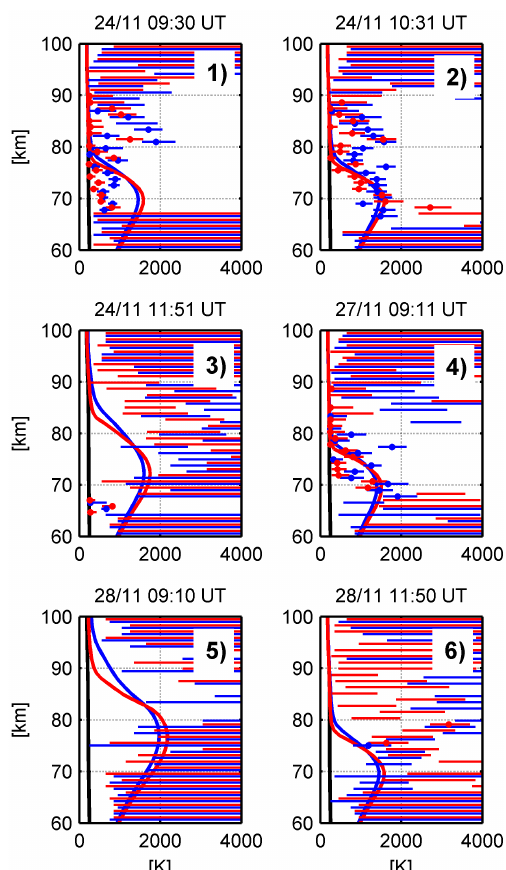
Fig. 5. Electron temperature estimates compared to heating model results (blue: o-mode, red: x-mode, black: heater off). Horizontal lines represent 90 percent significance widths of the MCMC pos- teriori distributions. Most probable values are marked with dots when the distribution width is less than 1000K. Continuous lines show modelled temperature profiles.